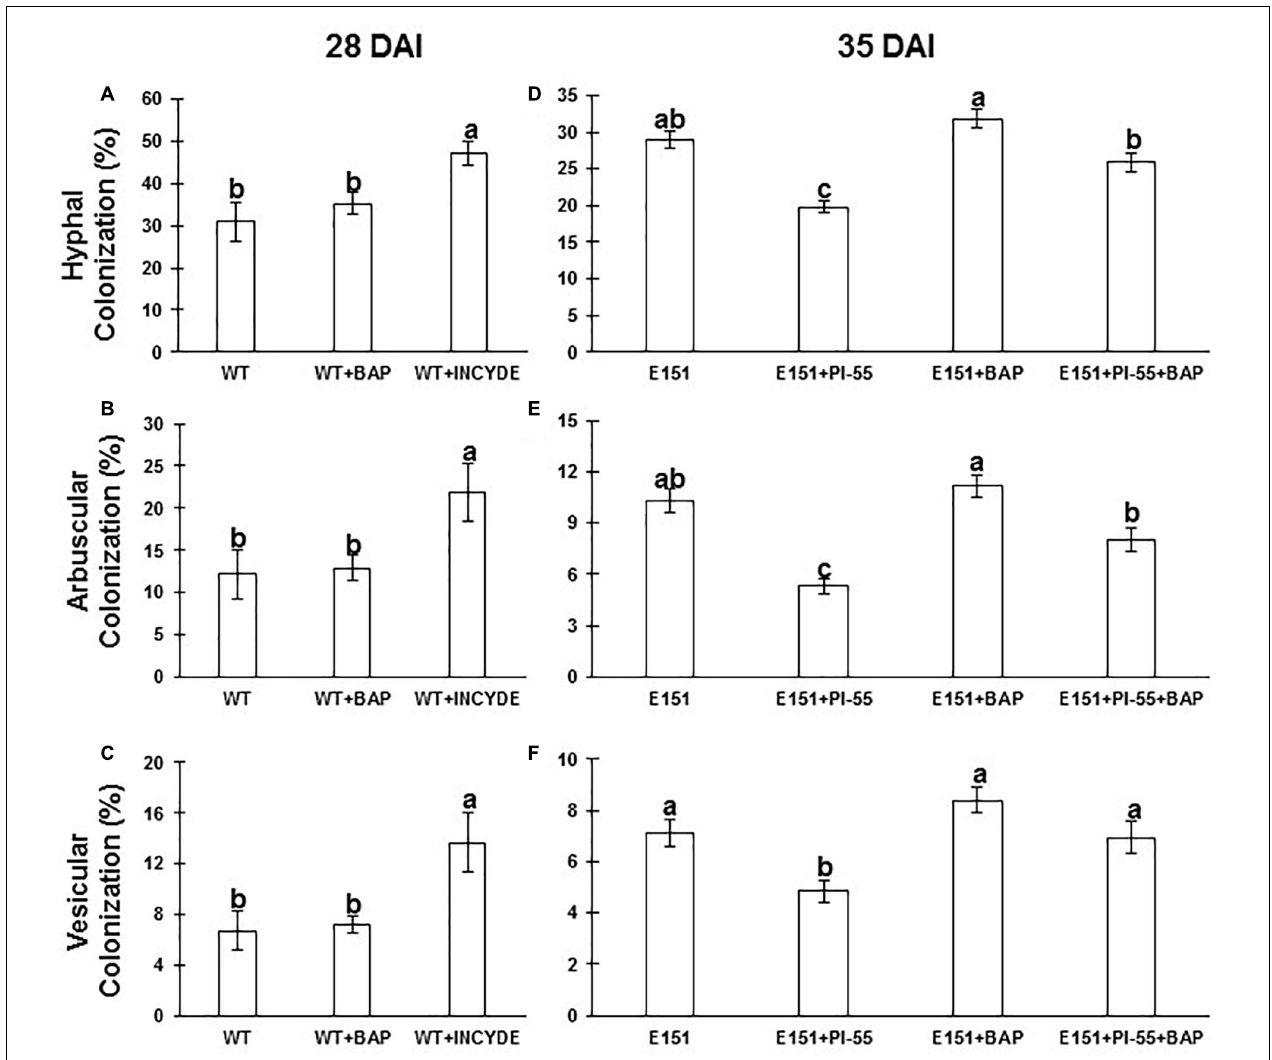
FIGURE 6 | Effect of synthetic CK status-modifying compounds on hyphal colonization (A,D) , arbuscular colonization (B,E) , and vesicular colonization (C,F) in the roots of WT (A–C) and E151 (D–F) plants inoculated with R. irregularis . Whereas WT plants were treated with BAP (0.1 µ M) and INCYDE (1 µ M), E151 plants were treated with PI-55 (10 µ M), BAP (1 µ M), and a combination of PI-55 and BAP. WT and E151 plants were harvested 28 and 35 days after inoculation (DAI), respectively. WT data (mean ± SE; n = 13, three technical replicates) and E151 data (mean ± SE; n = 15; three technical replicates) were either subjected to a one-way ANOVA followed by a Tukey’s HSD post hoc test, or a Kruskal–Wallis followed by a multiple comparisons test; significance (95% confidence level) is indicated by different